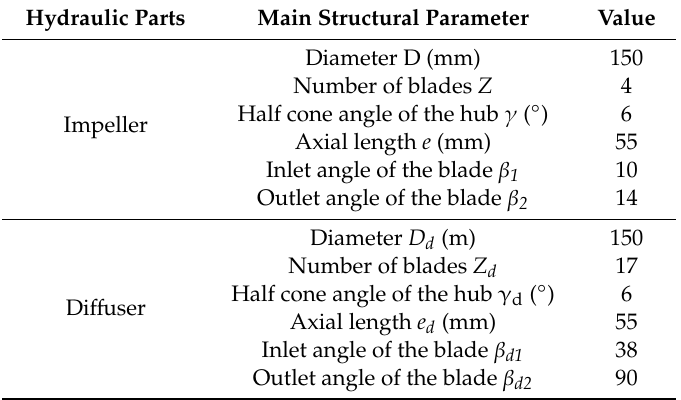
Table 3. Main parameters of the hydraulic parts of a multiphase